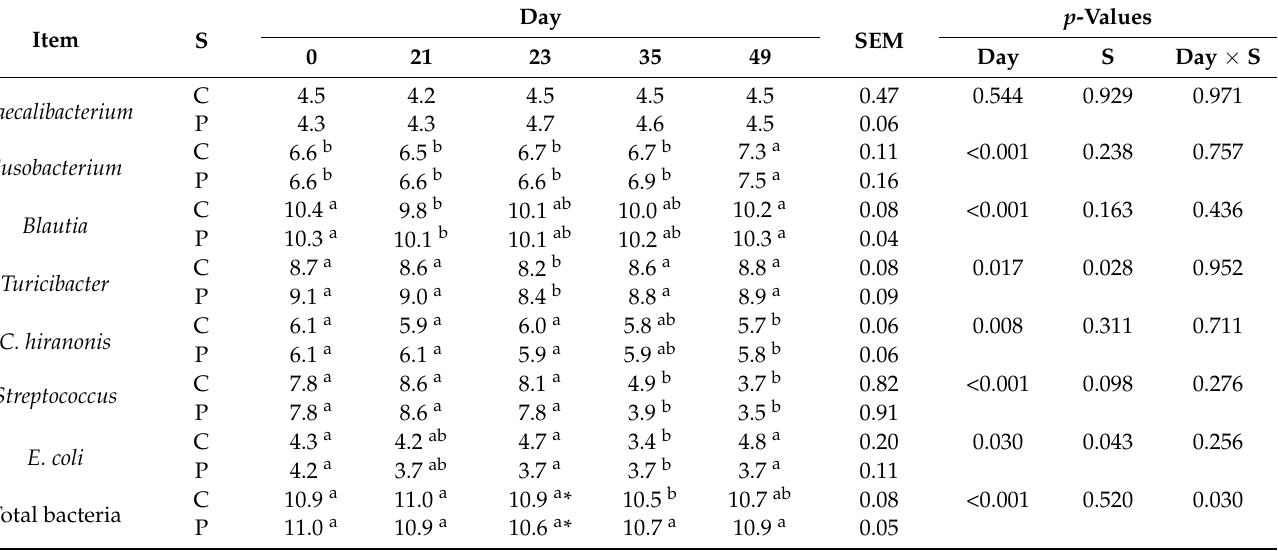
Table 5. Means of fecal concentration (logDNA) of selected bacterial groups of dogs fed a lower protein and fiber diet (day 21) transitioned to a higher protein and fiber diet (days 23 to 49) without (C) or with (P) yeast supplementation